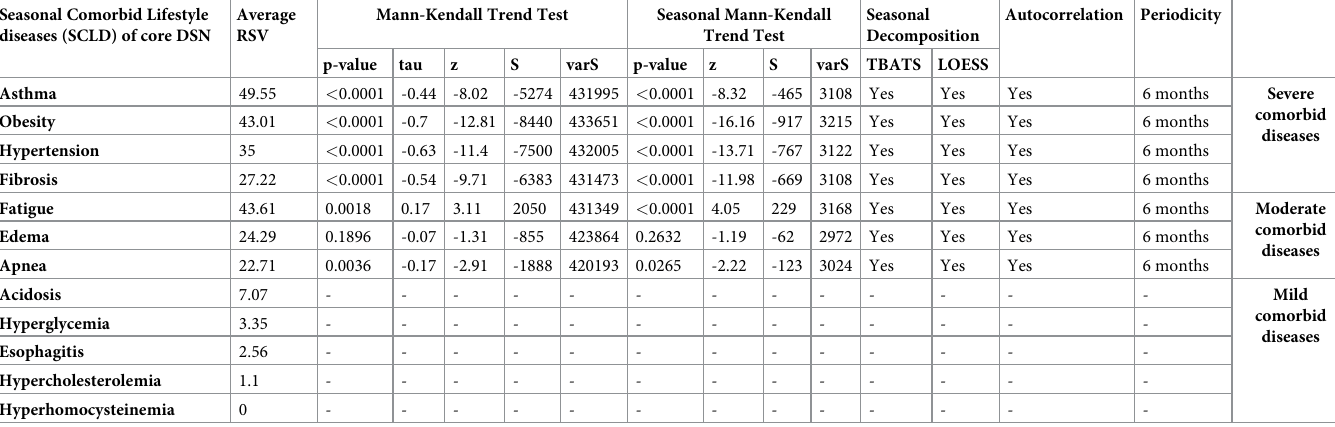
Seasonal Autocorrelation Periodicity Trend Test Decomposition